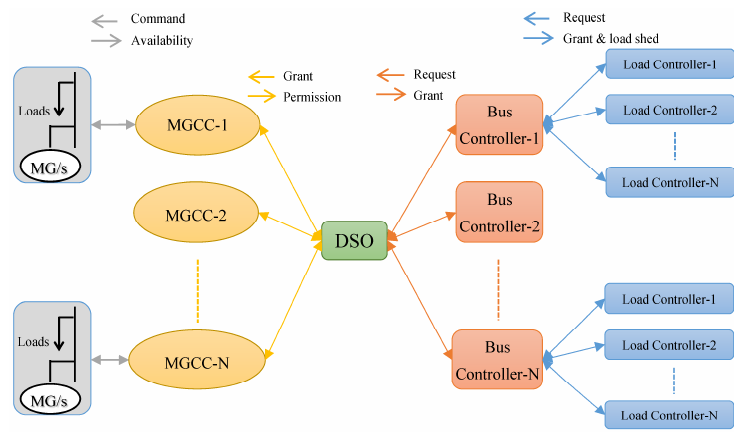
Figure 2. Grant/request process in the distribution network.